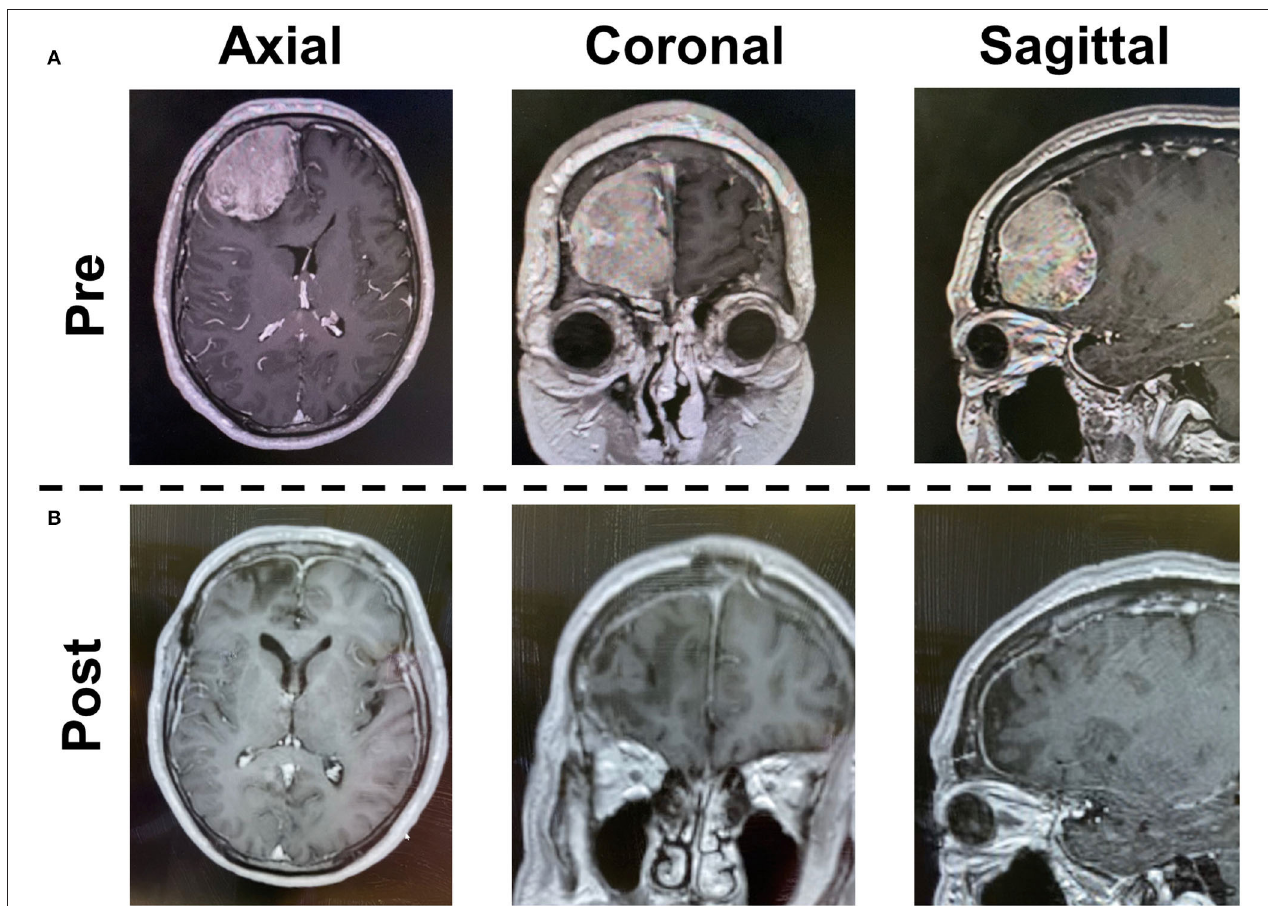
FIGURE 2 | Case presentation. Preoperative (A) and postoperative (B) gadolinium-enhanced T1-weighted imagings are